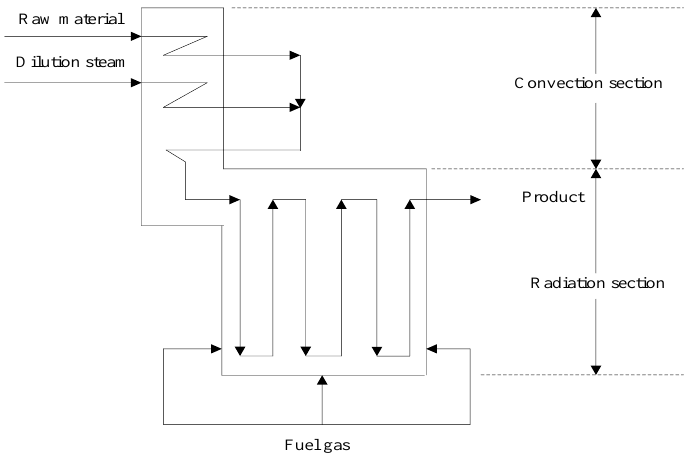
Figure 1. Structure diagram of the ethylene cracking furnace.